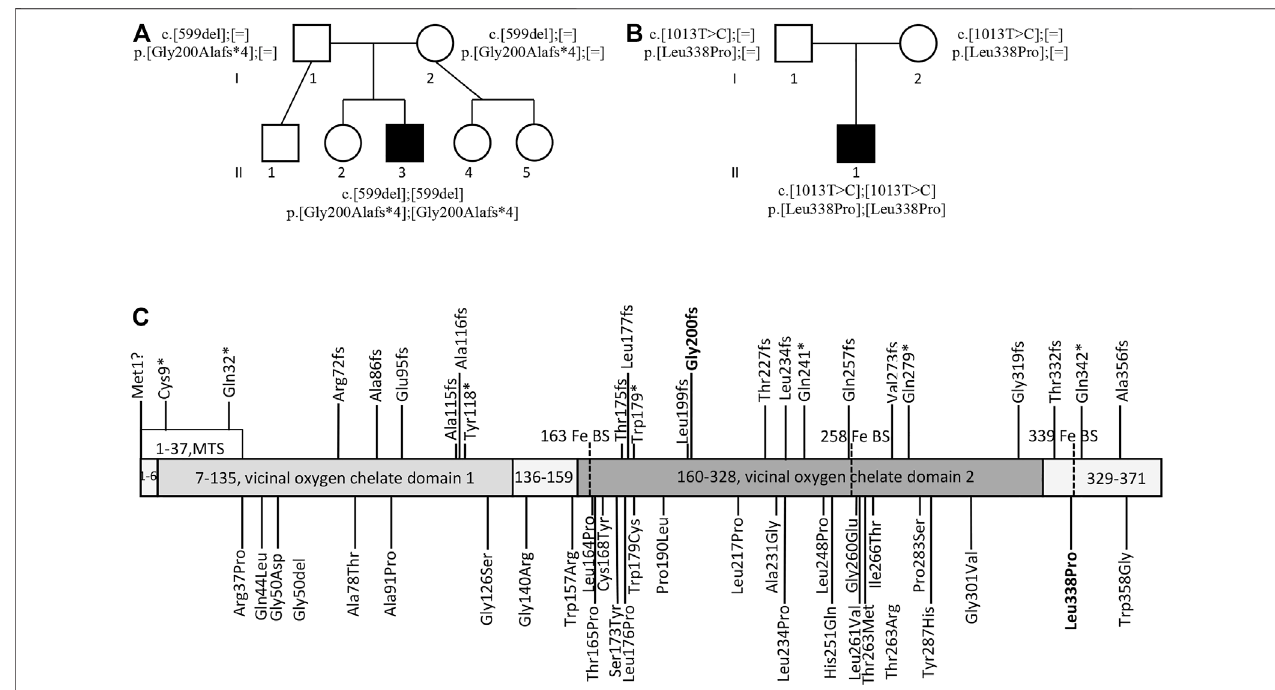
FIGURE 2 | The probands ’ pedigrees and HPDL variants. Pedigree of proband 1 (A) and proband 2 (B) with the harboured genotypes. Schematic of the HPDL protein and different disease-associated variants published so far (C) (Ghosh et al., 2020; Husain et al., 2020; Morgan et al., 2021; Numata-Uematsu et al., 2021; Sun et al., 2021; Wiessner et al., 2021; Yu et al., 2021). MTS, mitochondrial targeting sequence; Fe BS, iron binding site; variants reported in this manuscript are indicated in